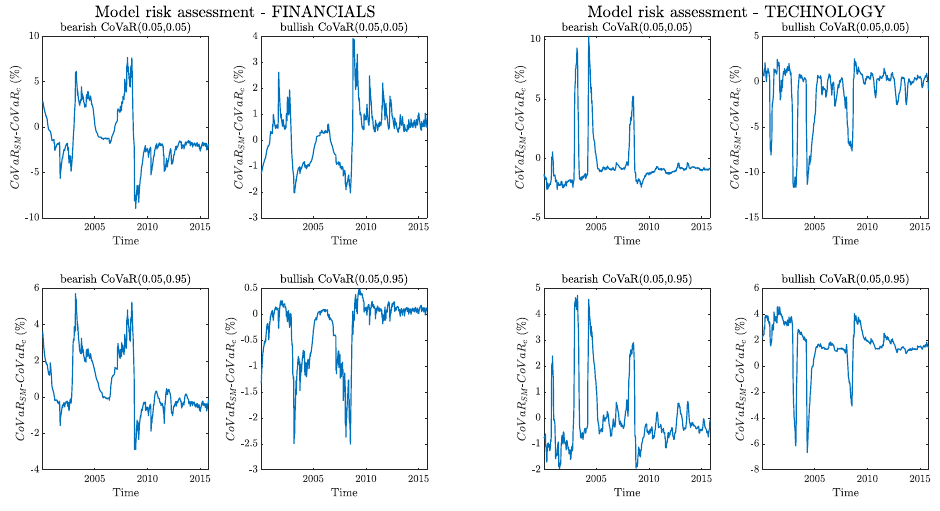
Figure 15c: Model risk assessment of when we assume a constant dependence compared to the time-varying